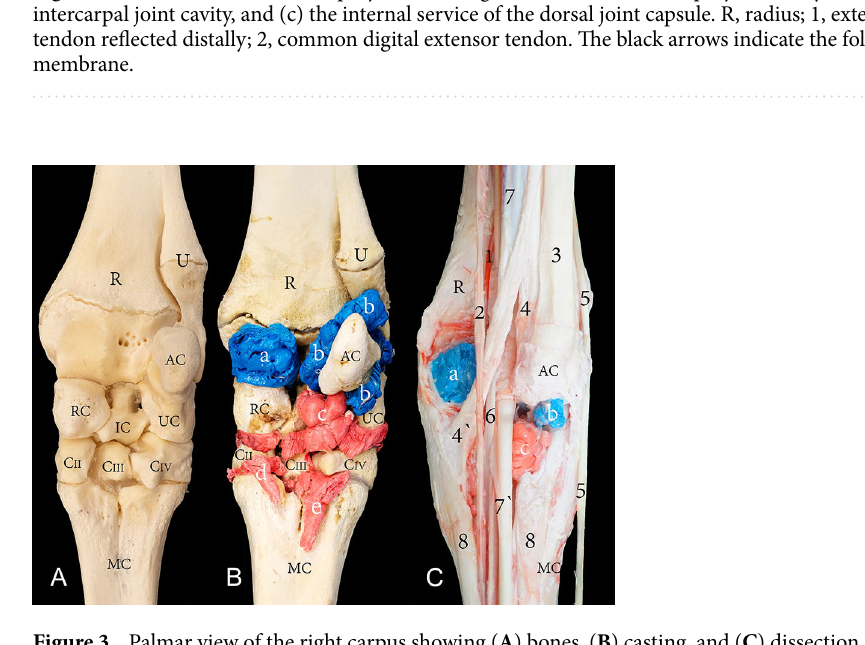
and inserts partly on the distal row of carpal bones. From this point, the fibrous layer continues to give rise to the carpometacarpal joint capsule. It finally inserts on the dorsal surface of the proximal part of the metacarpal bones. Figure 1B indicates the recesses formed by the joint capsule on the radius, the proximal carpal bones, and the distal carpal bones. The internal synovial membrane forms folds, which are exceptionally developed at the level between the articulating bones. These folds were found moulded into the casted material (Fig. 2). The capsule of the radiocarpal joint forms palmarly two pouches (Fig. 3B,C). The first pouch is located medio- palmar to the radius and the radial carpal bone (Fig. 4B,C). The second pouch is located lateropalmar to the radius and the intermediate carpal bone (Fig. 3B,C). The lateropalmar pouch surrounds the base of the accessory carpal bone. It extends lateropalmarly between the distal end of the ulna and the accessory carpal bone (Figs. 3B, 5B,C). The intercarpal joint forms a palmar pouch at the level of the intermediate carpal bone and carpal bone IV (Fig. 3B,C). At the medial and lateral origin of the interosseous medius muscle, the carpometacarpal joint forms two small pouches which extend distally on the palmar surface of the metacarpal bone (Figs. 3B, 4B, 5B). The small lateral pouch is located at the level of carpal bone IV and the metacarpal bone, and the small medial pouch is located at the level of carpal bone II and the metacarpal bone. There were no pouches found on the medial or lateral aspects of the carpus. However, a subtendinous synovial bursa was found proximal to the accessory carpal bone, located between the lateropalmar pouch and the flexor